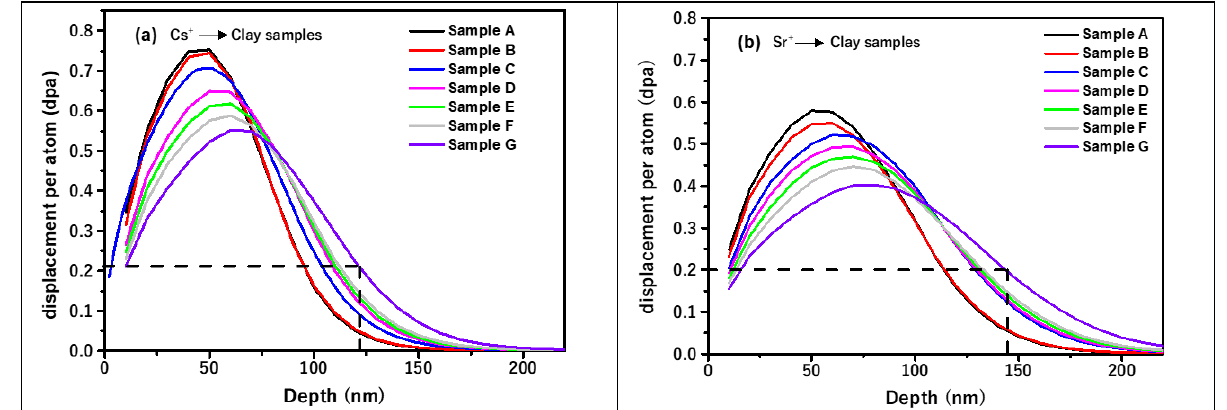
Figure 10. displacement per atom (dpa) profile of ( a ) Cs and ( b ) Sr ions in different clay samples.